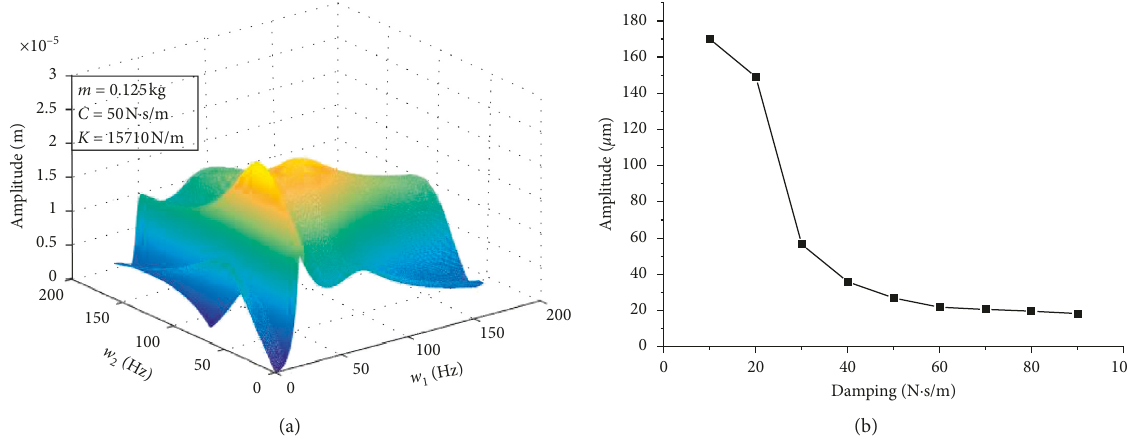
Figure 6: Effect of damping on the output spectrum. (a) Nonlinear output spectrum of C � 50N · s/m. (b) Relationship between damping and response peaks.